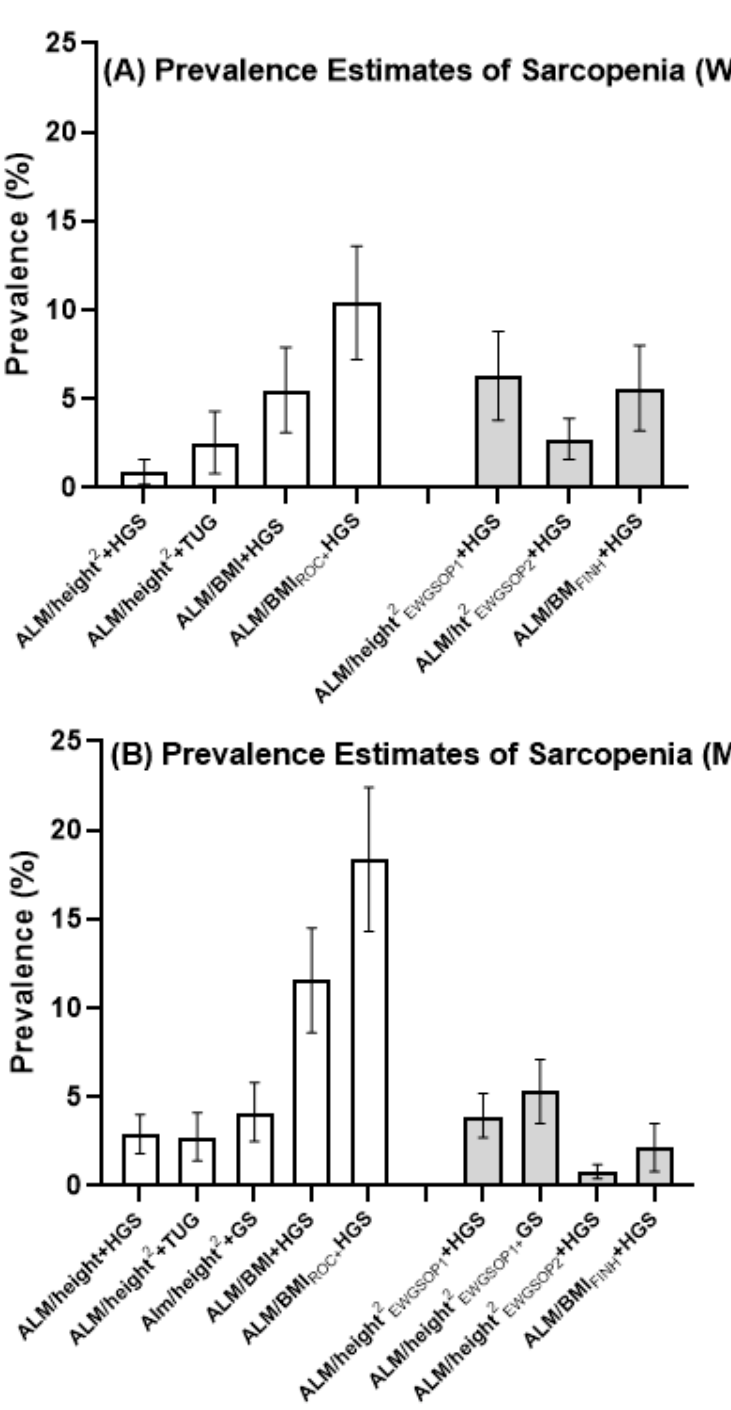
Figure 1. Prevalence estimates of sarcopenia for ( A ) women and ( B ) men aged 60 years and older. Error bars show 95% confidence intervals. Bars for estimates using population-specific cut-points are unshaded and those using international cut-points are shaded. EWGSOP : European Working Group on Sarcopenia in Older People; FNIH: Foundation for the National Institutes of Health; ALM: appendicular lean mass; GS: gait speed; HGS: handgrip strength; BMI: body mass index; TUG: timed up-and-go.